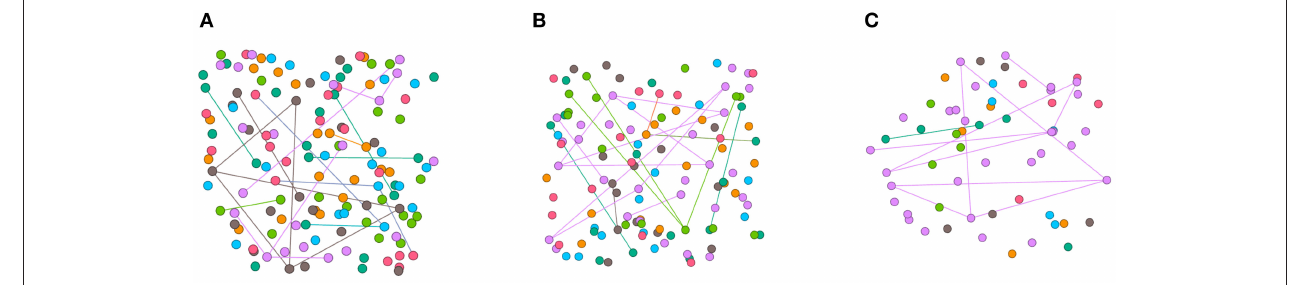
FIGURE 2 | Visualization of synthetic imbalanced datasets. (A) shows the classical Cora training set. (B) shows the training set when s is fetched 15. (C) shows the training set when s is fetched 5. The mean degrees of the nodes in (A–C) are 0.30, 0.30, 0.37